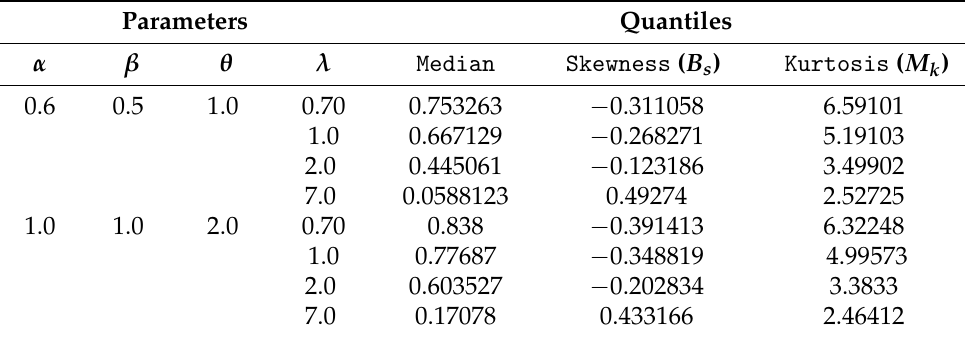
Table 1. Quantiles for TLMW